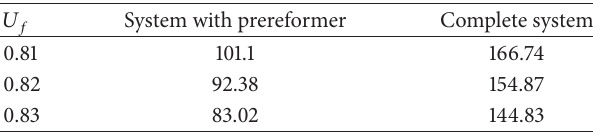
Table 5: Comparison between the gas turbine power plant with prereformer and complete system for dfc = 2500 A/m 2 .